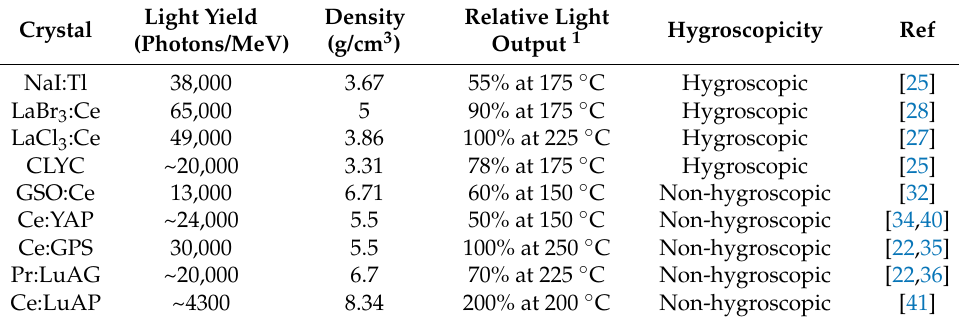
Table 1. Scintillator list and critical parameters for radiation detector used in the well- logging